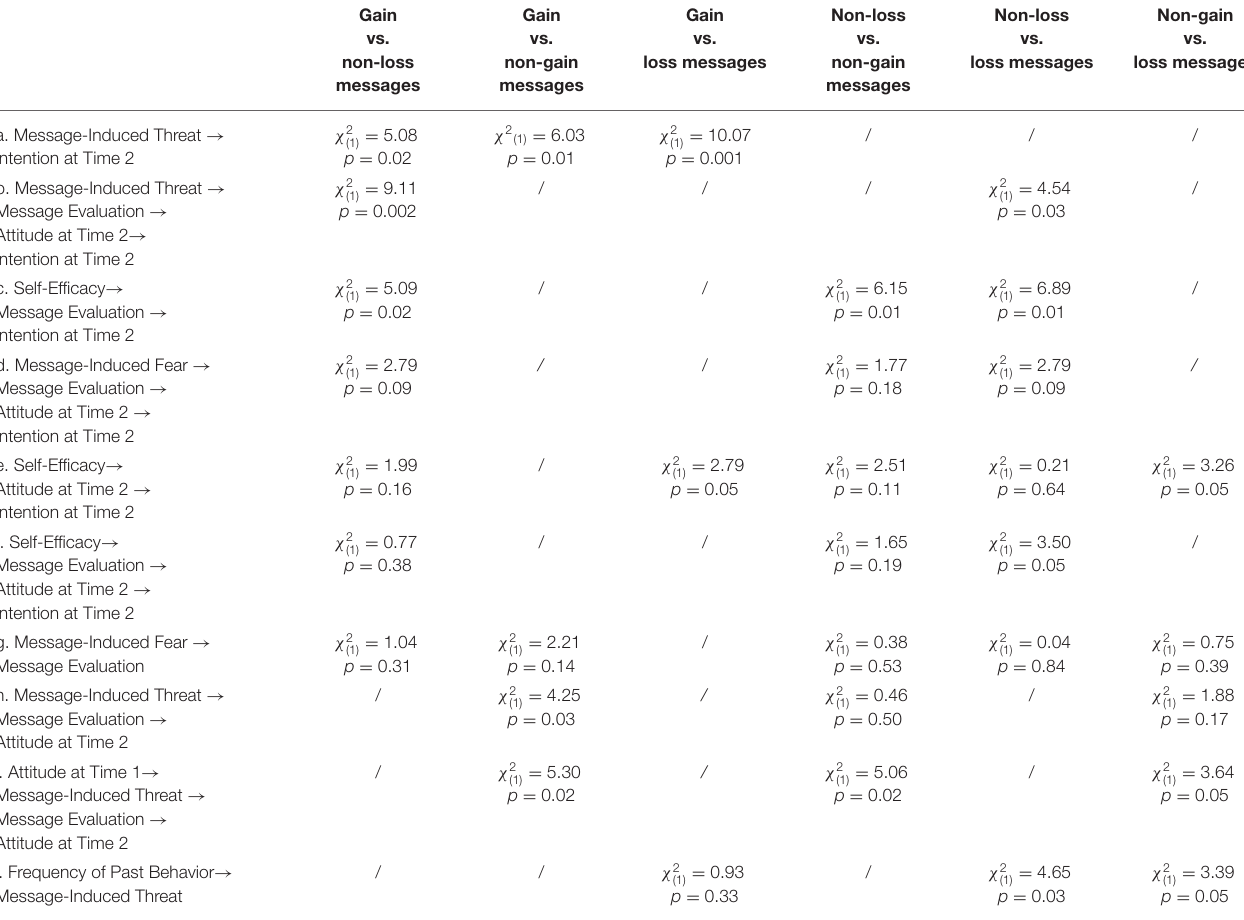
TABLE 3 | Results of the comparisons of the main significant paths among message groups.